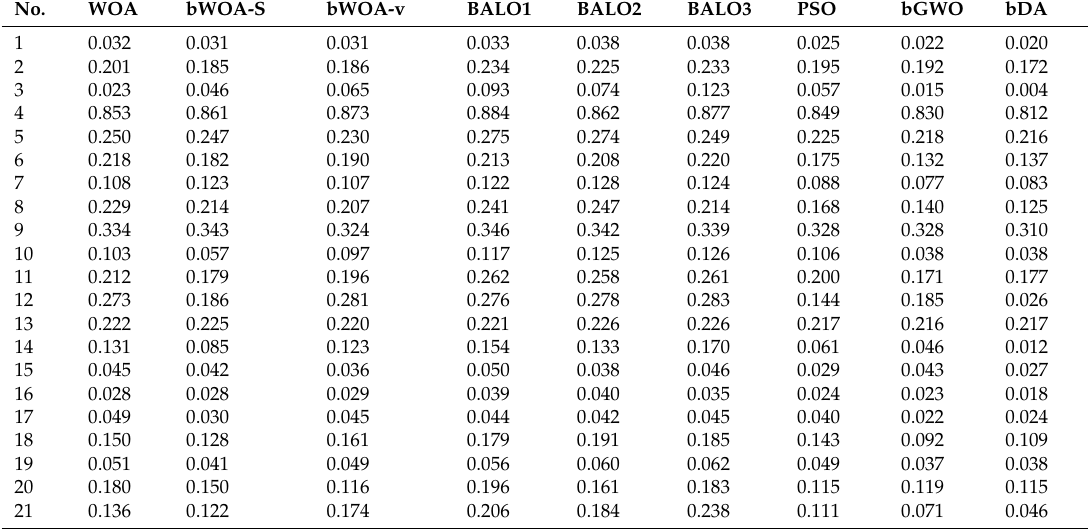
Table 12. Best fitness function on the different datasets averaged for the compared algorithms over the three initialization methods.